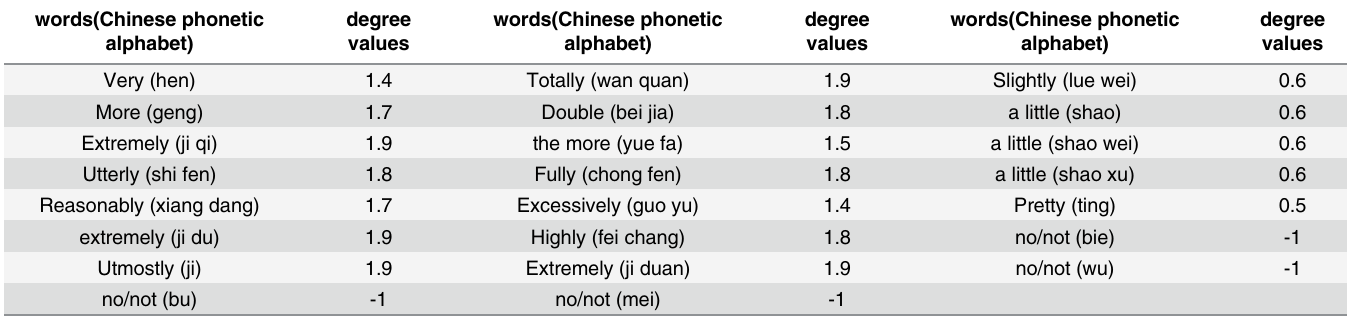
Table 1. Some words ’ degree values in the degree adverbs